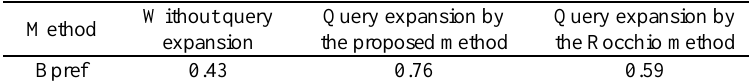
Table 3. Mean Bpref for results of the considered